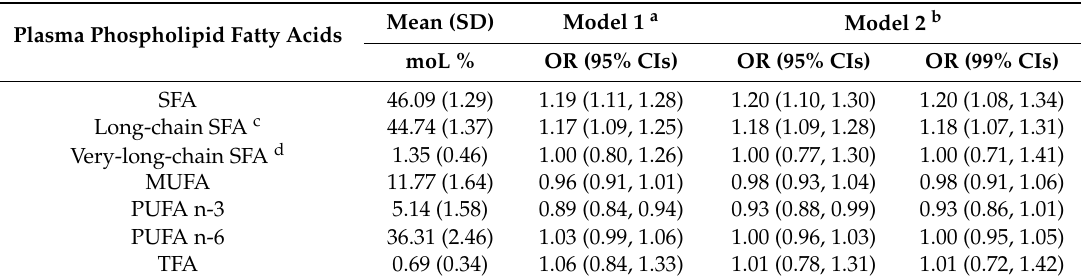
Table 3. Multivariable adjusted associations (1 moL %) between plasma phospholipid fatty acids and CHD risk in the matched case-control study ( N = 2428).